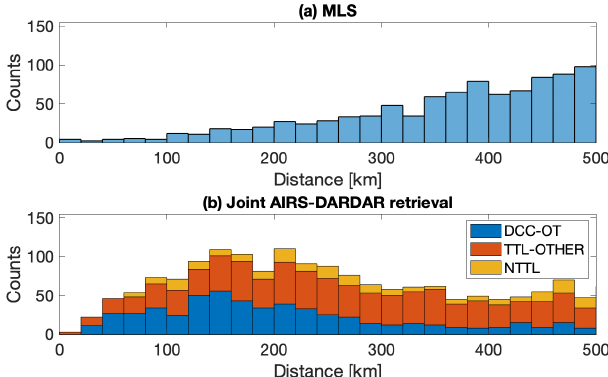
Figure 5. Sample densities used for assessing temperature and humidity distributions from (a) MLS and (b) the joint AIRS– DARDAR